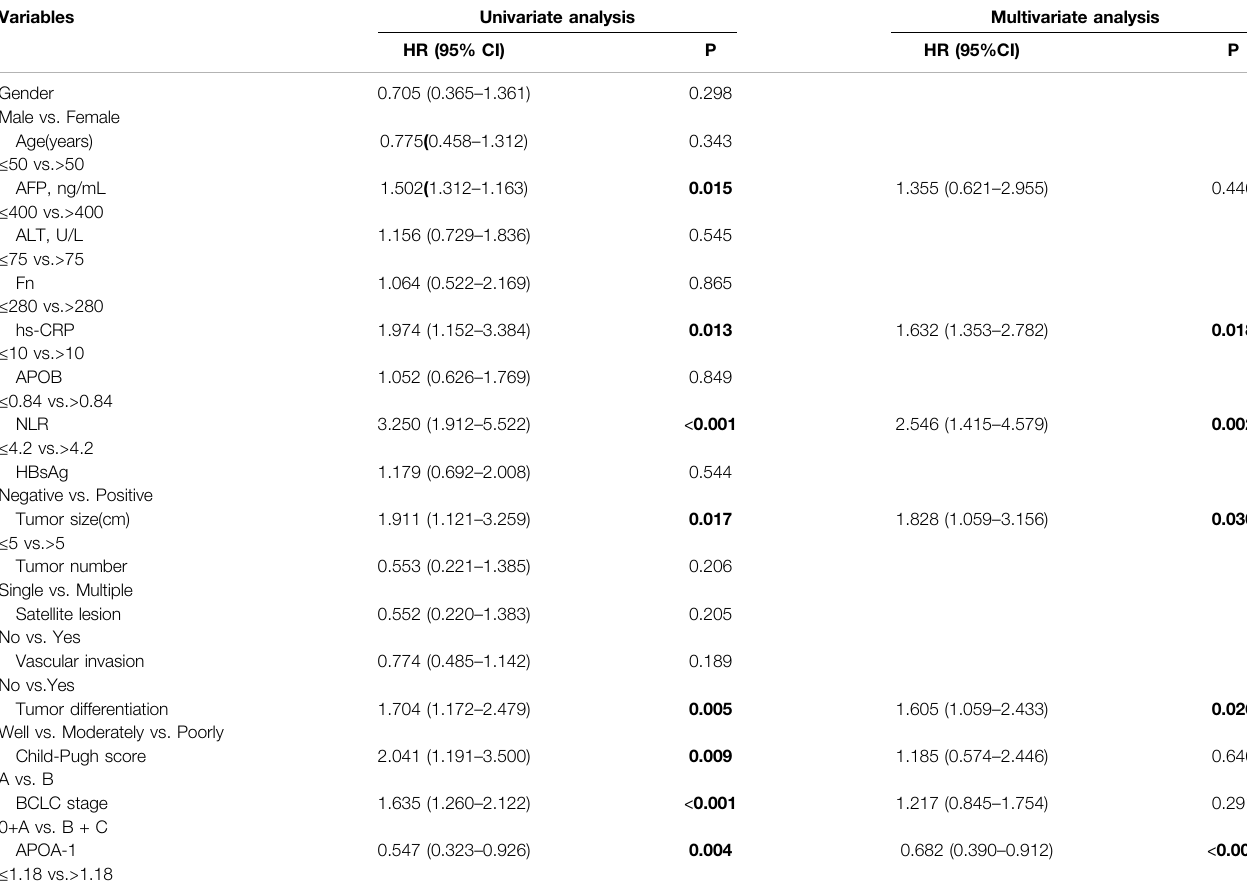
TABLE 4 | Univariate and multivariate cox hazards analysis for Progression-free survival in 316 patients with HCC.